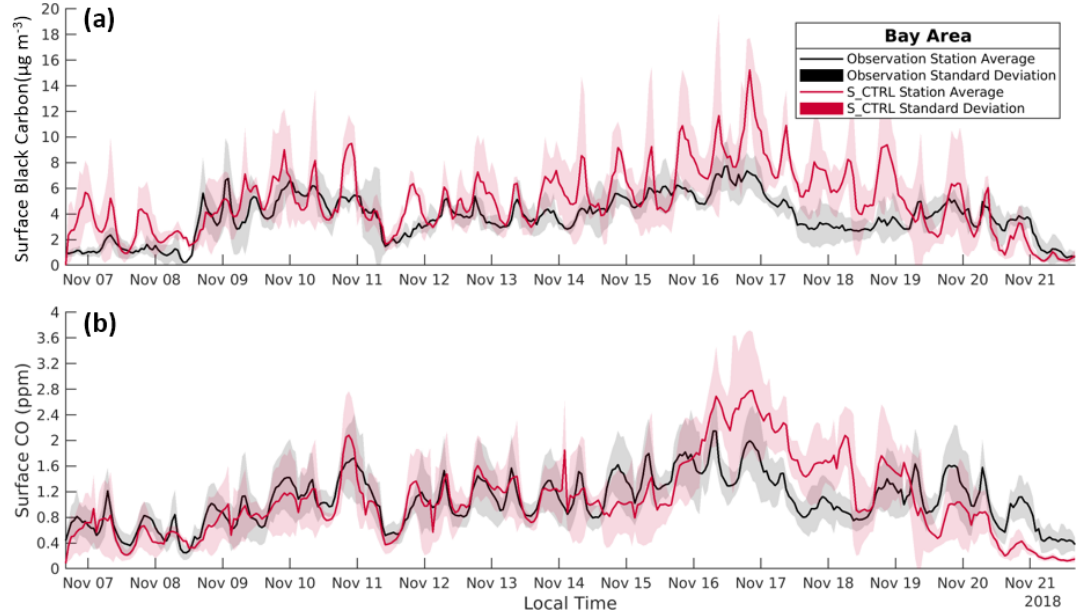
Figure 7. Comparison of AQS surface black carbon ( a , N = 5) and carbon monoxide ( b , N = 12) observations (black) with S_CTRL predictions (red) at monitoring sites in the Bay Area. S_CTRL captures the temporal evolution of BC and CO and is close to observed values. BC peaks are often overpredicted. The greatest bias of BC and CO occurs during 16–18 November, likely due to the scale factor applied to emissions during 13–16